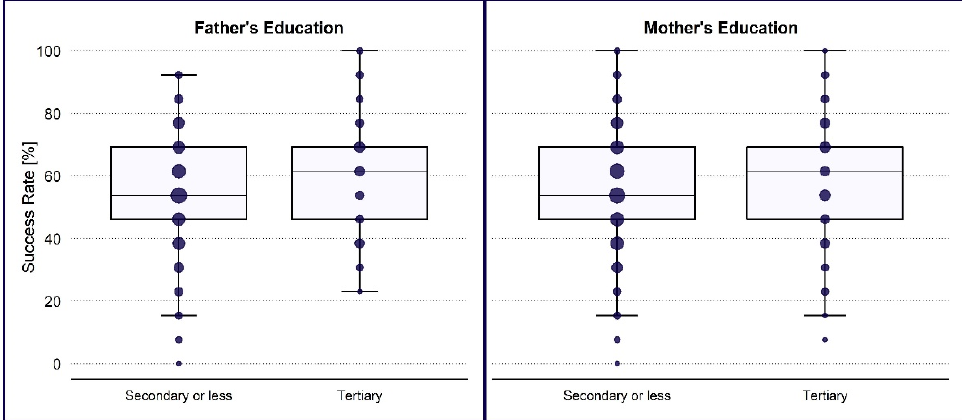
Figure 3. Success rate of students in the financial literacy test depending on the parents’ education.